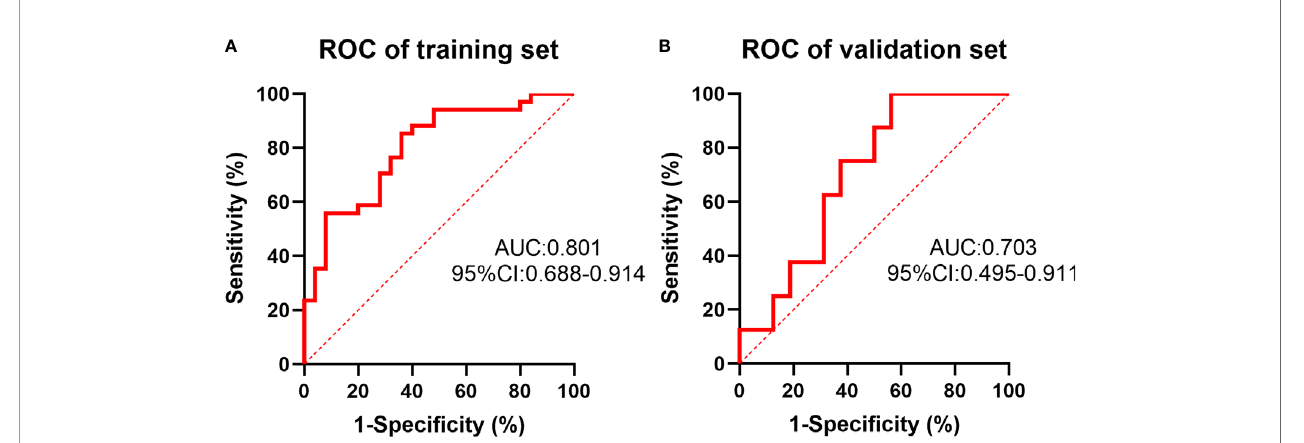
FIGURE 3 | The receiver operating characteristic (ROC) curve of the prediction of KRAS status by the radiomics model in the training set (A) and validation set (B) .